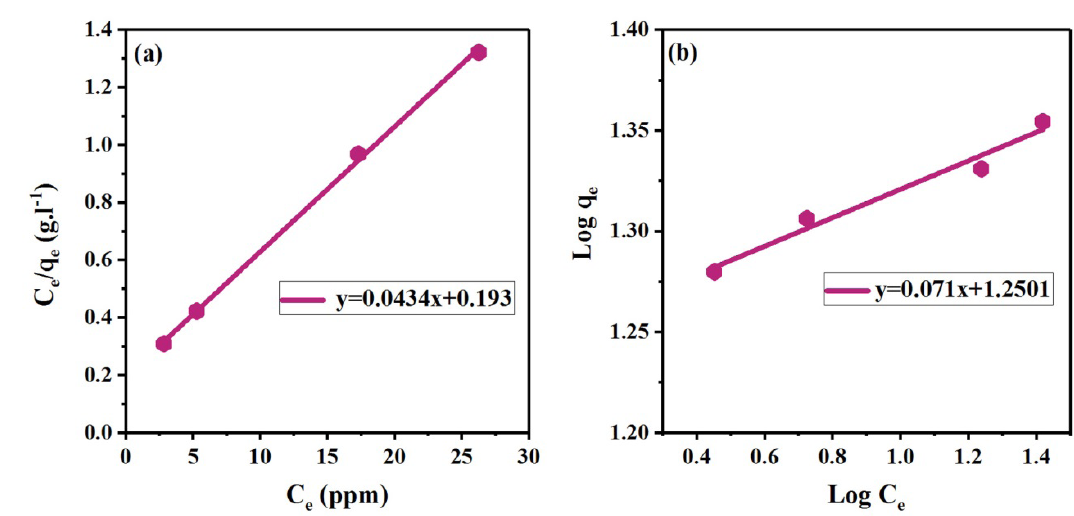
O /CeO /Ag CNPs 2 3 2 O /CeO /Ag sample. 2 3 2